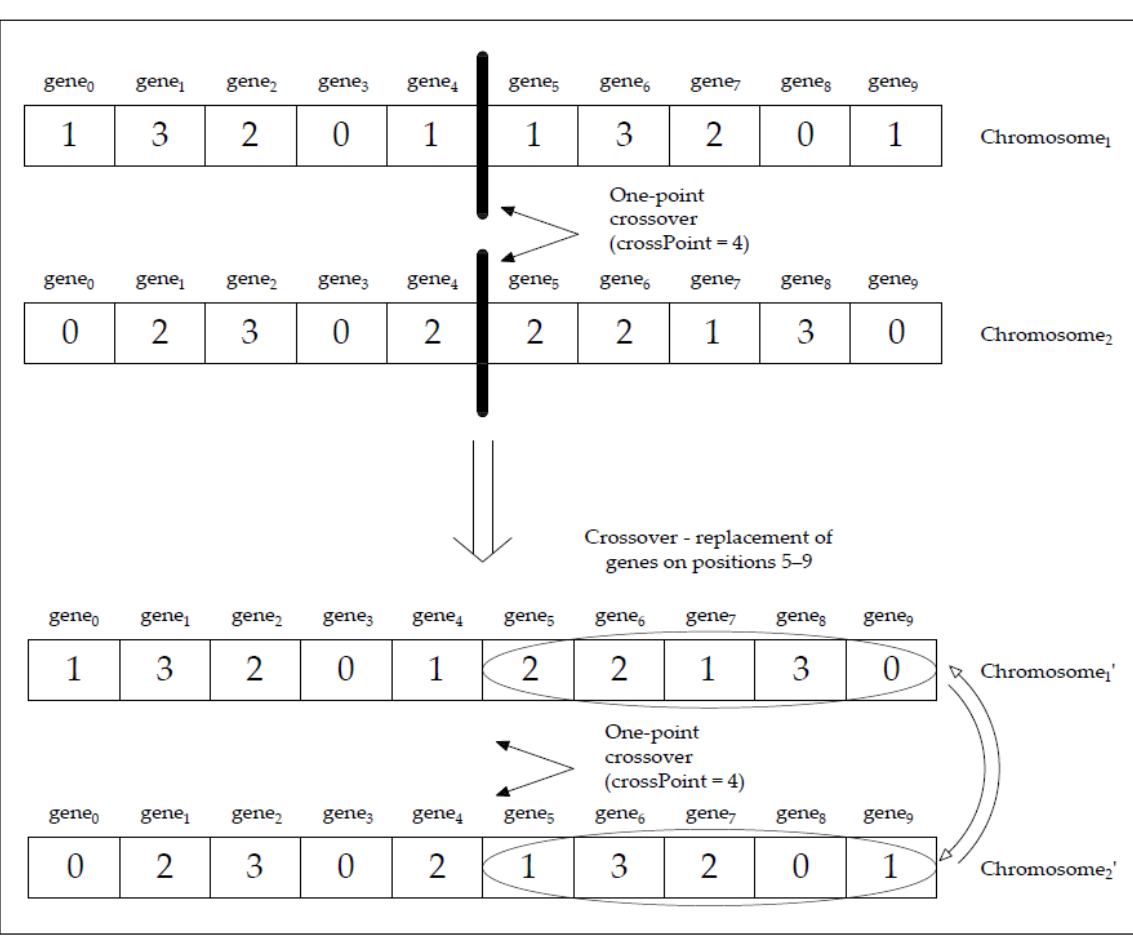
Figure 10. The one-point crossover example.